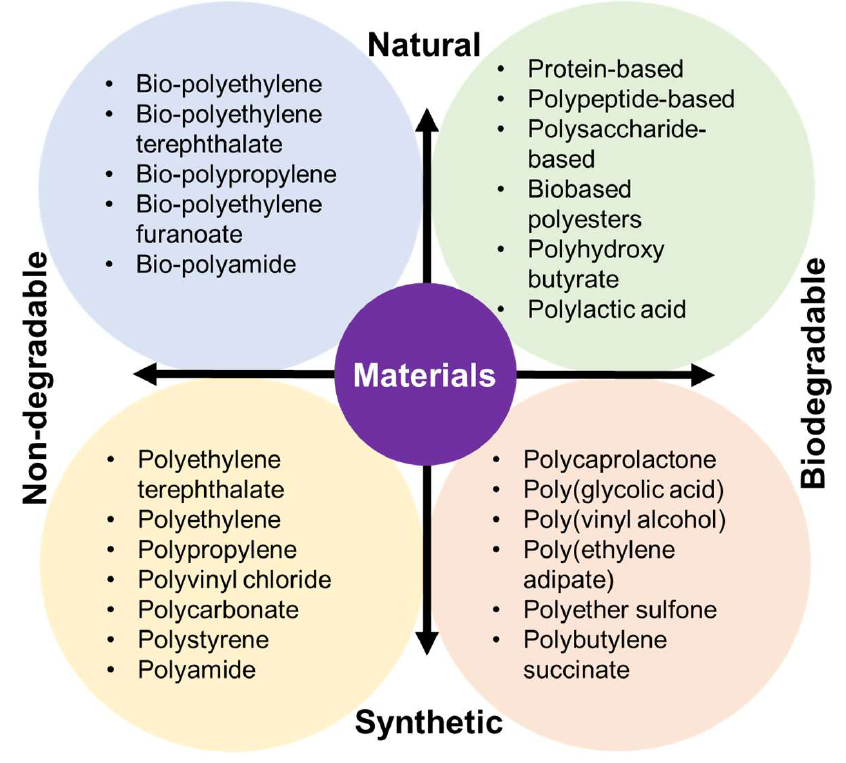
Figure 1. Classification of biomaterials used to prepare 3D scaffolds according to their sources and biodegradability.